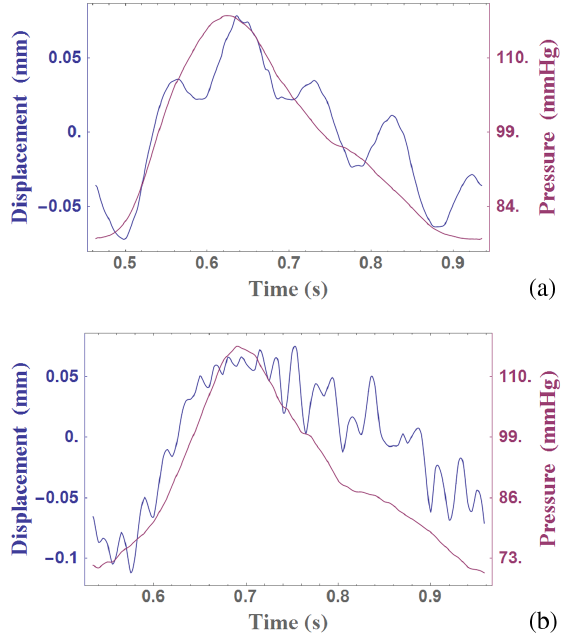
FIG. 9. Bending displacement of one period showing vibra- tions; red line, pressure; blue line, lateral displacement at mid- length of the aortic segment. (a) Donor XVIII at 126 bpm in the horizontal direction, showing vibrations at 10.1 Hz; (b) donor XVI at 155 bpm in the horizontal direction showing vibrations at 46.4